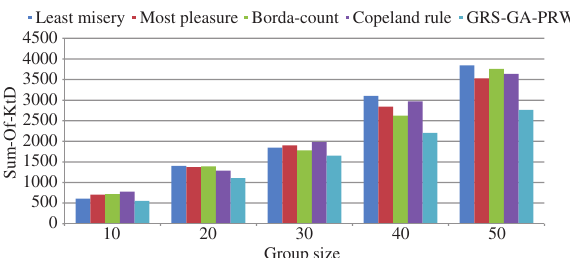
Figure 13: The Effectiveness of Proposed GRS-GA-PRWT Compared to Baseline Techniques Based on Different Group Sizes.